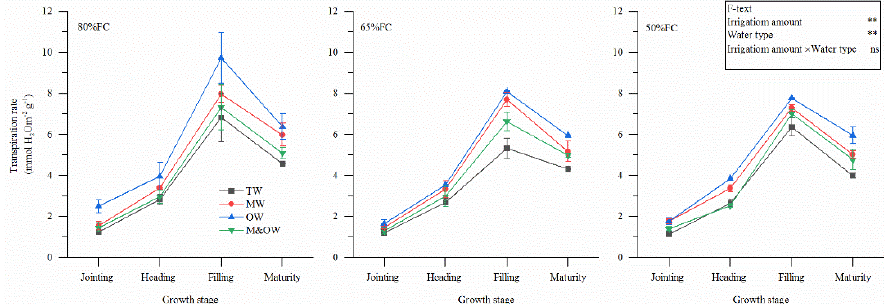
Figure 7. Effect of tap water (TW), magnetized water (MW), oxygenated water (OW), and magnetized and oxygenated water (M&OW) irrigation on stomatal conductance of winter wheat with 80%FC, 65%FC, and 50%FC irrigation amounts in the different growth stages. Irrigation amount × water type represents the effect of interaction between irrigation amount and water type. * identifies significant differences at p < 0.05, respectively, and ns identifies no significant differences. The error bars indicate standard deviations.